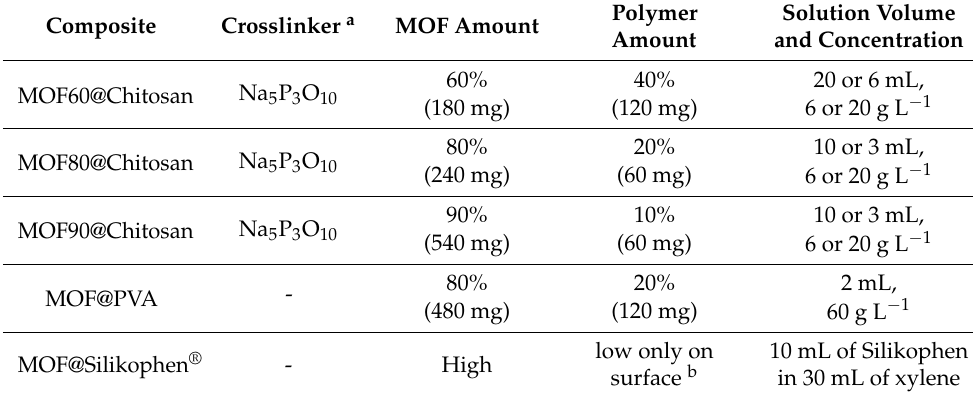
Table 1. Details of the relative and absolute MOF and polymer amounts.